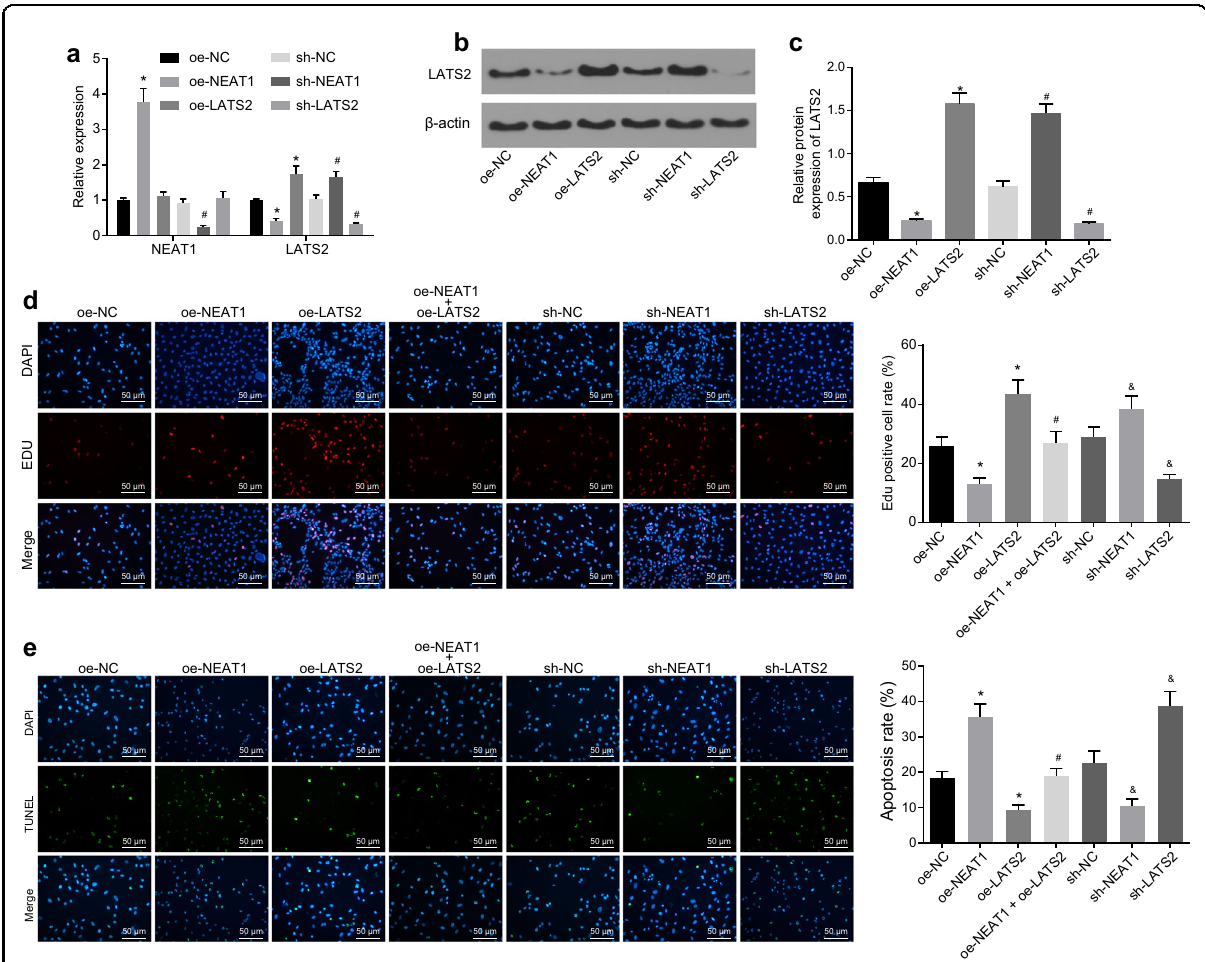
Fig. 2 Knockdown of lncRNA NEAT1 inhibits apoptosis and induces cell proliferation by modulating LATS2. The expression patterns of lncRNA NEAT1 and LATS2 in cells treated with oe-NEAT1, oe-LATS2, sh-NEAT1, or sh-LATS2 evaluated by RT-qPCR ( a ). The protein expression patterns of LATS2 in cells treated with oe-NEAT1, oe-LATS2, sh-NEAT1, or sh-LATS2 evaluated by western blot analysis ( b ). Quanti fi cation of protein expression from b ( c ). * p < 0.05 vs. the oe-NC group; # p < 0.05 vs. the sh-NC group. The proliferation of HL-7702 cells treated with sh-NEAT1, sh-LATS2, oe-NEAT1, and/or oe-LATS2 measured by the EdU assay (×200) ( d ). The apoptosis of HL-7702 cells treated with sh-NEAT1, sh-LATS2, oe-NEAT1, and/or oe-LATS2 measured by TUNEL staining (×200) ( e ). * p < 0.05 vs. the oe - NC group; # p < 0.05 vs. the oe-LATS2 group; & p < 0.05 vs. the sh-NC group. oe-NC group, HL-7702 cells treated with oe-NC; oe-NEAT1 group, HL-7702 cells treated with oe-NEAT1; oe-LATS2 group, HL-7702 cells treated with oe-LATS2; sh- NEAT1 group, HL-7702 cells treated with sh-NEAT1; sh-LATS2 group, HL-7702 cells treated with sh-LATS2; oe-NEAT1 + oe-LATS2 group, HL-7702 cells treated with both oe-NEAT1 and oe-LATS2. Statistical data are described as mean ± standard deviation. One-way analysis of variance was used for comparisons among multiple groups, followed by Tukey ’ s post hoc test. The experiment was repeated three times independently. RT-qPCR reverse transcription quantitative polymerase chain reaction, lncRNA NEAT1 long noncoding RNA nuclear-enriched abundant transcript 1, LATS2 large tumor- suppressor kinase 2, EdU 5-ethynyl-2 ′ -deoxyuridine, TUNEL terminal deoxynucleotidyl transferase (TdT)-mediated 2 ′ -deoxyuridine 5 ′ -triphosphate (dUTP) biotin nick end labeling, NC negative